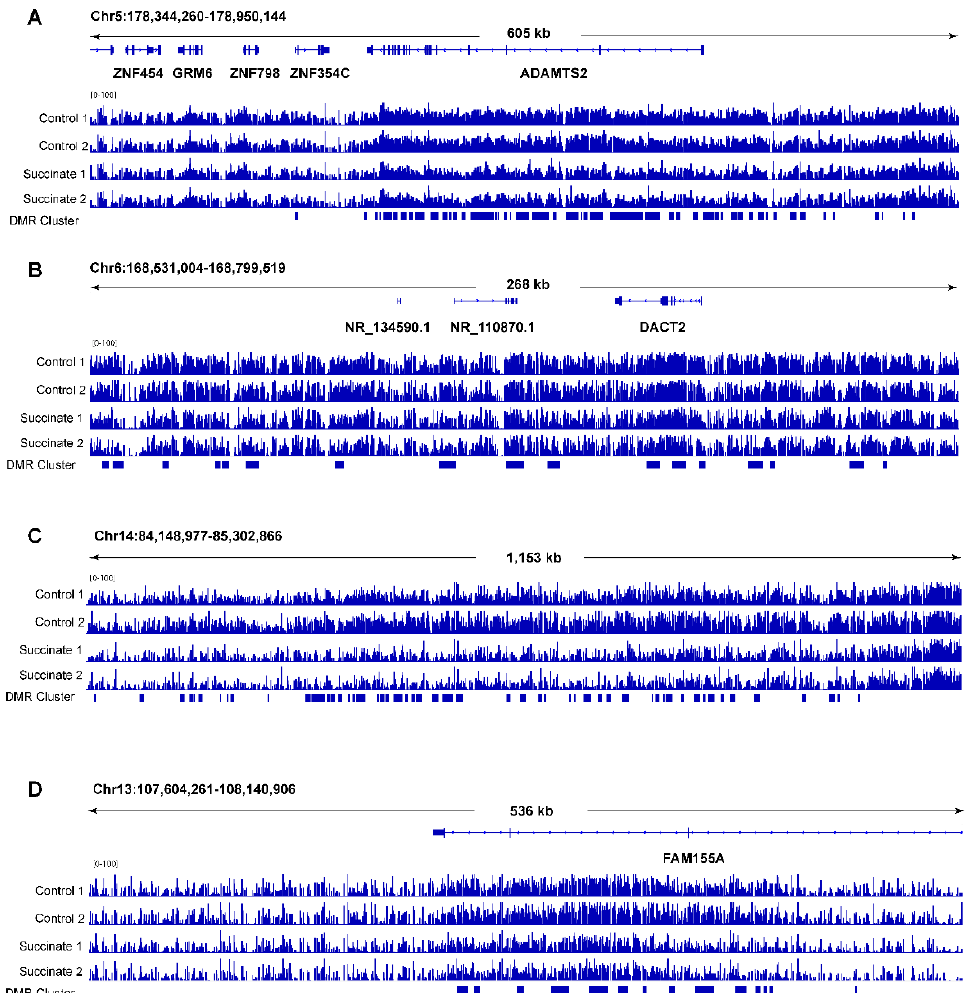
Figure 4. Examples of clustered DNA hypomethylated regions in succinate-treated human bronchial epithelial cells. ( A ) A locus on chromosome 5 encompassing the ADAMTS2 gene. The clustered hypomethylated DMRs in succinate-treated cells are marked with blue bars in the bed file at the bottom of the panels. ( B ) A locus on chromosome 6 showing several hypomethylated DMRs within 250 kb as indicated by the blue bars. ( C ) A locus on chromosome 14 showing several hypomethylated DMRs as indicated by the blue bars. ( D ) A locus on chromosome 13 at the FAM155A gene. The clustered hypomethylated DMRs in succinate-treated cells are marked with blue bars in the bed file at the bottom of the